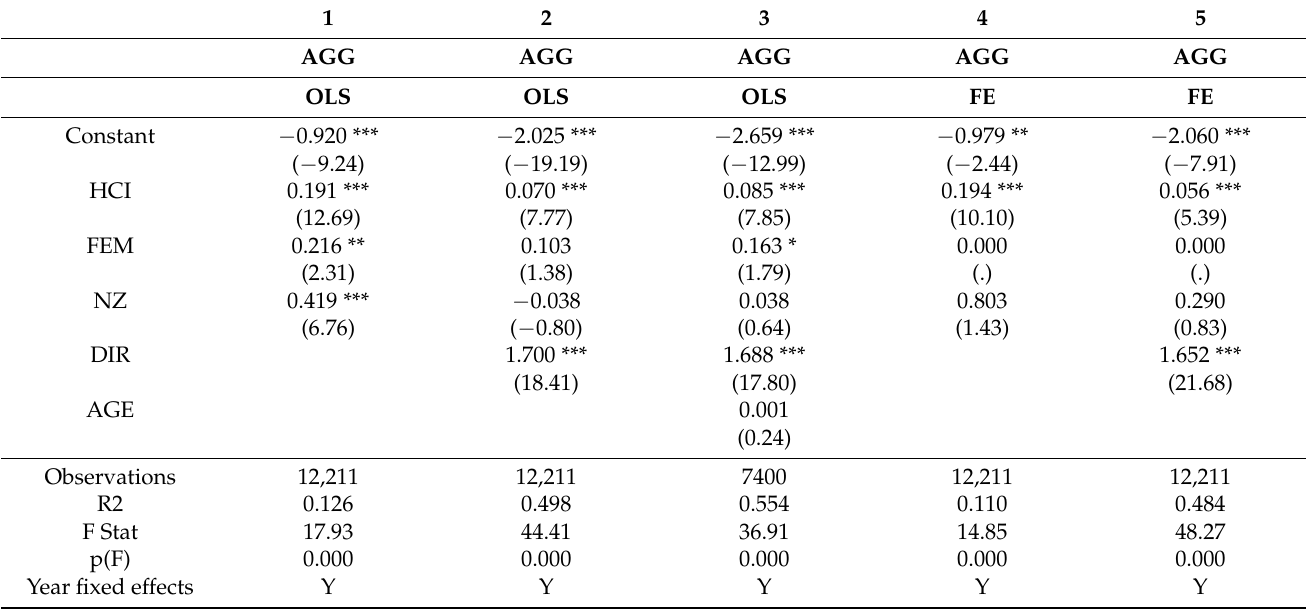
Table 5. OLS regressions for the relationship between human and social